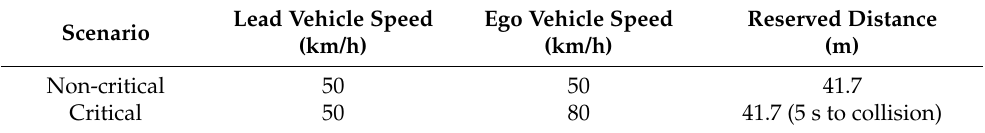
Table 2. Setting of stimulation